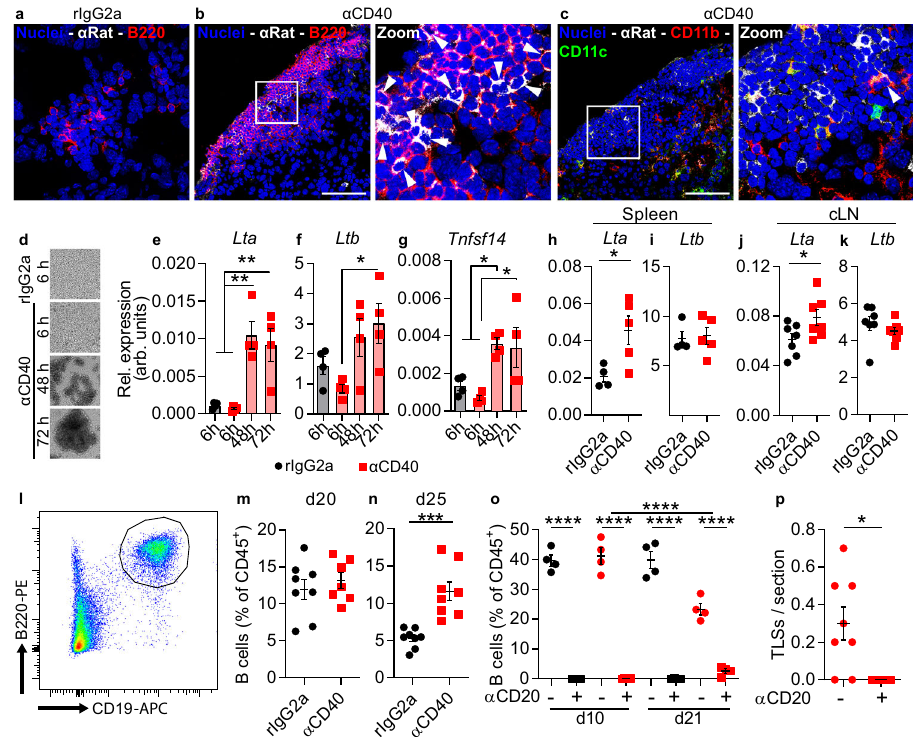
Fig. 2 B cells expressed LT α upon α CD40 stimulation and were required for TLS formation. All panels except ( d – g ) show data from GL261 tumor- bearing mice treated with rIgG2a or α CD40. a – c Immuno fl uorescent staining of therapeutic rat antibodies ( α Rat) in TLS co-stained for a , b B220 and c CD11b and CD11c. Images are representative of three mice. Arrows: cells positive for α Rat. White square areas are magni fi ed to the right in b , c . Scale bars: 50 µ m. d Representative images of murine CD19 + splenic B cells stimulated in vitro with rIgG2a or α CD40 antibodies at indicated time points. e – g Gene expression of Lta, Ltb , and Tnfsf14 in B cells shown in d . n = 4 independent experiments. One-way ANOVA with Dunnett ’ s correction for multiple comparison. In e p (rIgG2a 6h vs. α CD40 48h) = 0.0017, p (rIgG2a 6h vs. α CD40 72h) = 0.005, p ( α CD40 6h vs. α CD40 48h) = 0.0012, p ( α CD40 6h vs. α CD40 72h) = 0.0035. In f p ( α CD40 6h vs. α CD40 72h) = 0.0223. In g p (rIgG2a 6h vs. α CD40 48h) = 0.0439, p ( α CD40 6h vs. α CD40 48h) = 0.0105, p ( α CD40 6h vs. α CD40 72h) = 0.0169. h – k Gene expression of Lta and Ltb in CD19 + B220 + B cells sorted from h , i spleen and j , k cranial lymph nodes. h , i n (rIgG2a) = 4 mice, n ( α CD40) = 5 mice. j , k n = 7 mice/group. h p = 0.0285, j p = 0.0452. Two-tailed t -test, * p < 0.05. l Representative plot of quanti fi cations shown in m , n . m Quanti fi cation of CD19 + B220 + brain-in fi ltrating B cells as a percentage of CD45 + cells at day 20. n (rIgG2a) = 8 mice; n ( α CD40) = 7 mice. n Quanti fi cation of CD19 + B220 + brain-in fi ltrating B cells as a percentage of CD45 + cells at day 25. n = 8 mice/group. p = 0.0003. m , n Two-tailed t -test. o Quanti fi cation of CD19 + B220 + B cells as a percentage of CD45 + cells in the blood of tumor-bearing mice treated with rIgG2a or α CD40 antibodies, with ( + ) or without ( − ) B cell depletion with an α CD20 antibody. n = 4 mice/group. All indicated p -values are p < 0.0001. One-way ANOVA with Tukey ’ s correction for multiple comparison. p Quanti fi cation of the number of dense CD45 + B220 + clusters per 80 µ m-thick section in α CD40-treated tumor-bearing brains with ( + ) or without ( − ) B cell depletion with an α CD20 antibody. n ( α CD40) = 8 mice, n ( α CD20 + α CD40) = 5 mice. * p = 0.0234. Two-tailed t -test. h – n Black circle indicates rat IgG2a (rIgG2a), red square indicates agonistic CD40 antibodies ( α CD40). o , p Black circle indicates rIgG2a, black square indicates rIgG2a + α CD20, red circle indicates α CD40, red square indicates α CD40 + α CD20. For all graphs in this fi gure, * p < 0.05, ** p < 0.01, *** p < 0.001, **** p < 0.0001. Bars: mean ± SEM. arb. units = arbitrary units. Source data are provided as a Source Data fi